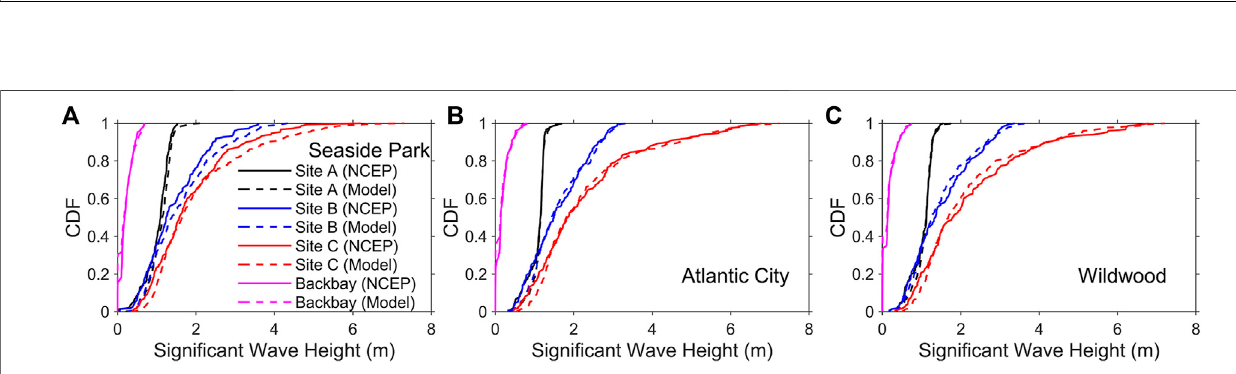
FIGURE 5 | Cumulative distribution function (CDF) of historical SWH at the selected sites ( Figure 1 for the location of sites).